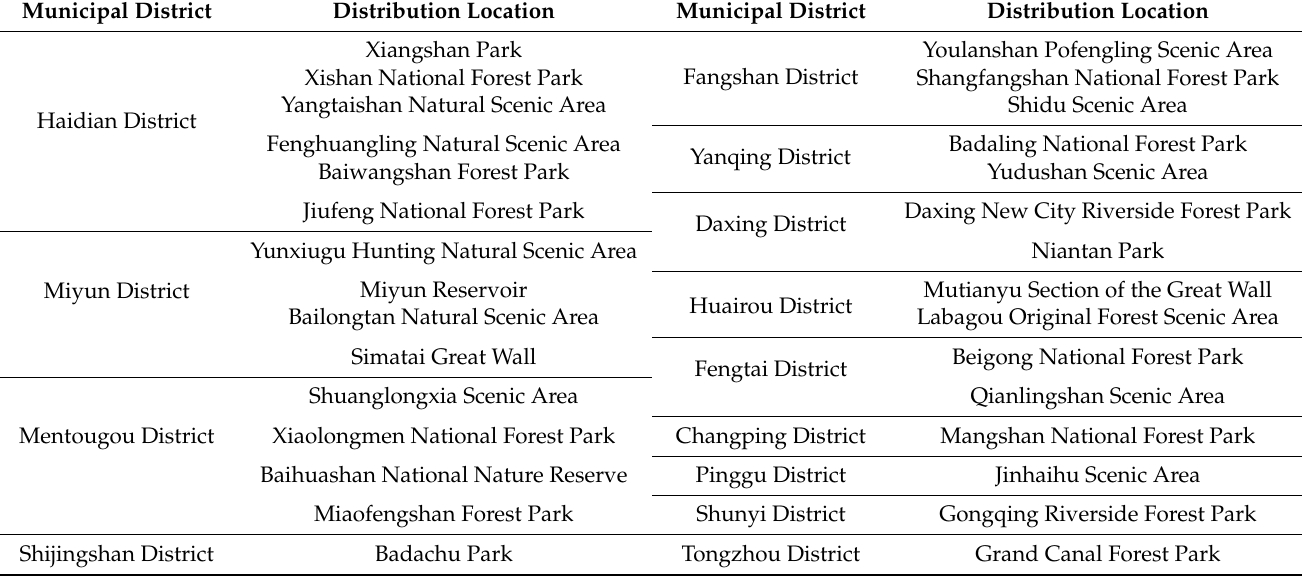
Table 1. Main sites to plant Cotinus coggygria var. cinerea Engl. forest in Beijing. Municipal District